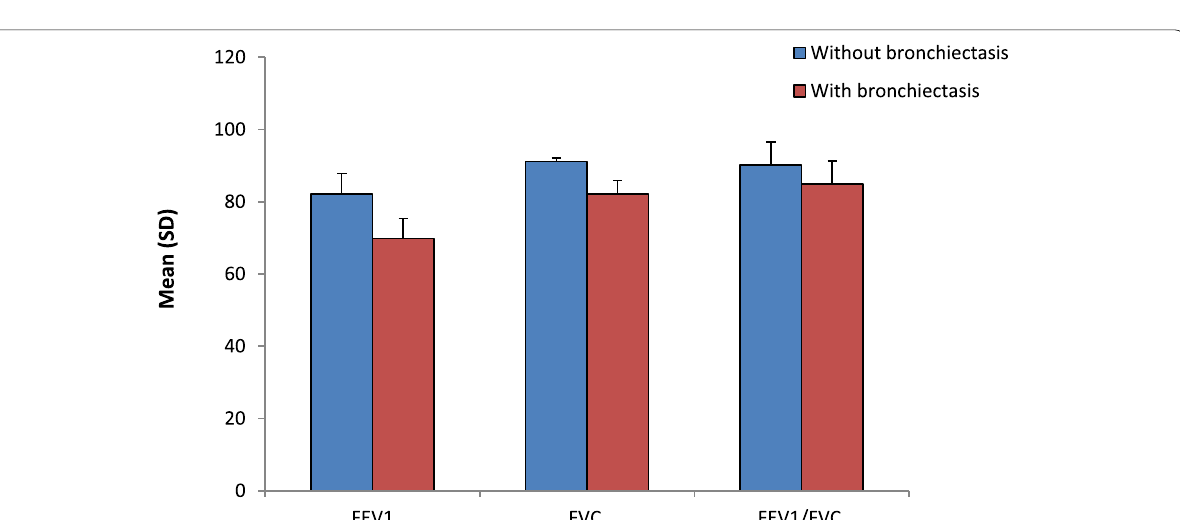
Fig. 3 Pulmonary function test among studied TB patients (after conversion to sputum negative) based on the presence of bronchiectasis ( N FEV1 forced expiratory volume in 1st second; FVC forced vital